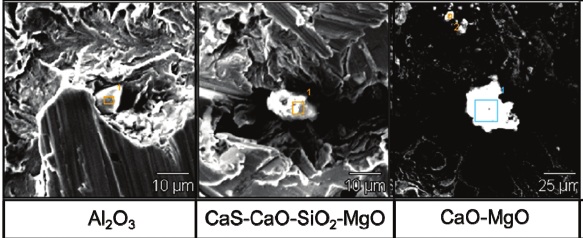
Figure 2: Inclusions in fracture of drill